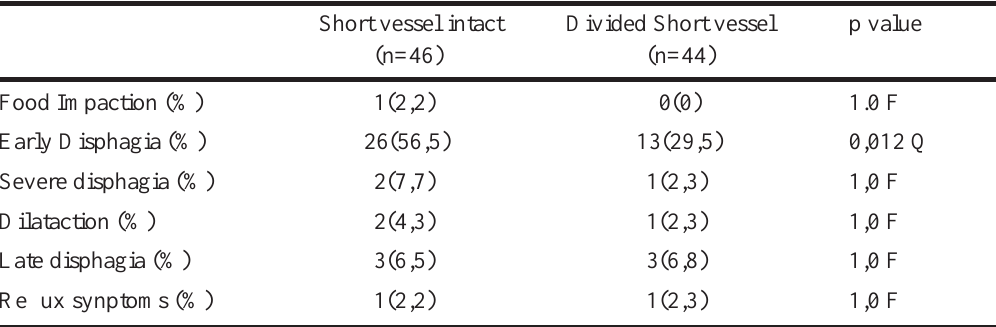
TABLE 4 - First year follow-up Short vessel intact Divided Short